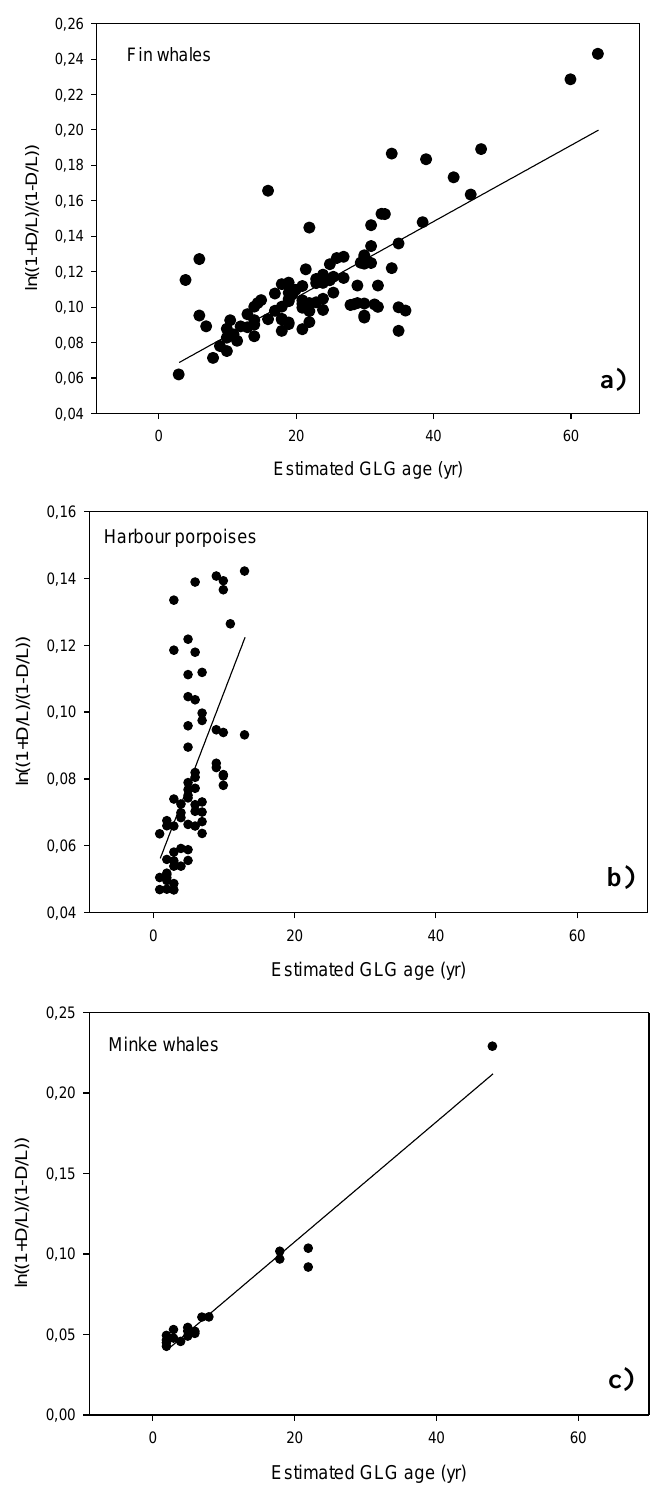
Fig. 2a-c. Linear regression between GLG ages and D/L content in fin whales [y=0.0021 (±0.0002)x + 0.062 (±0.004), n=98, R² = 0.59, P <0.0001], harbour porpoises [y=0.0006 (±0.0009)x + 0.051 (±0.006), n=66, R² = 0.36, P <0.0001] and minke whales [y=0.004 (±0.0002)x + 0.033 (±0.003), n=19, R² = 0.96, P